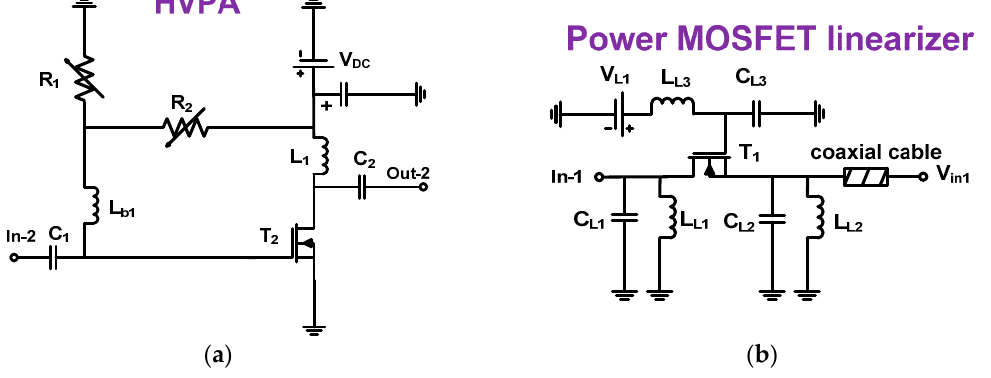
Figure 2. Schematic diagrams of ( a ) HVPA and ( b ) power MOSFET linearizer.